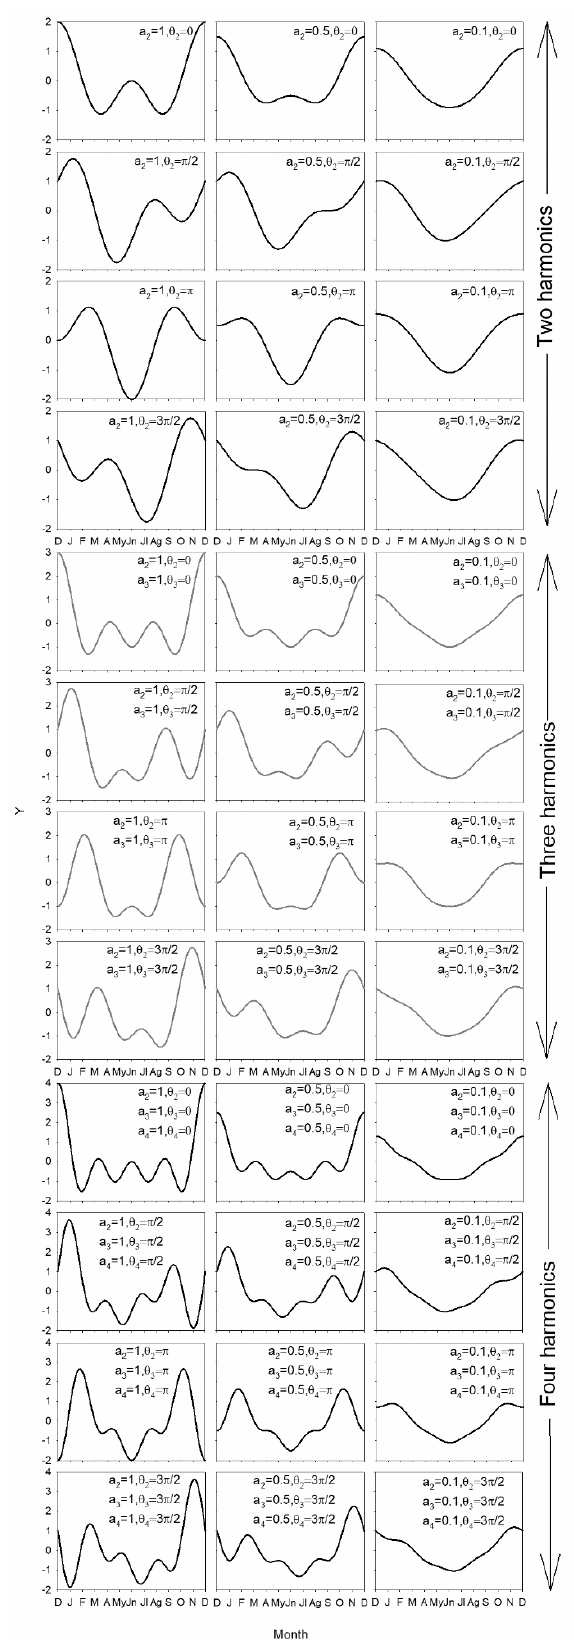
Figure 3. Representation of Equation (3) with a 0 = 0, a 1 = 1, θ 1 = 0, T 1 = 12 months, T 2 = 6 months, and varied values of a 2 and θ 2 , labelled as two harmonics. The addition of the third and fourth harmonics (T 3 = 4 and T 4 = 3 months) is also plotted.